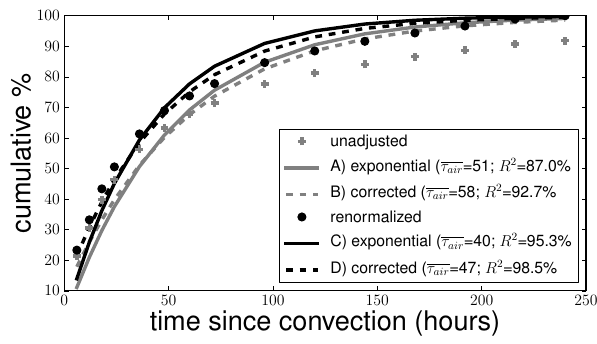
Fig. 2. Optimization results for stochastic convection using the ex- ponential and bias-corrected statistical model with the unadjusted and renormalized back trajectory dataset. (A) exponential model (Eq. 1) with unadjusted dataset; (B) bias-corrected model (Eq. 2) with renormalized dataset; (C) exponential model with unadjusted dataset; (D) bias-corrected model with renormalized